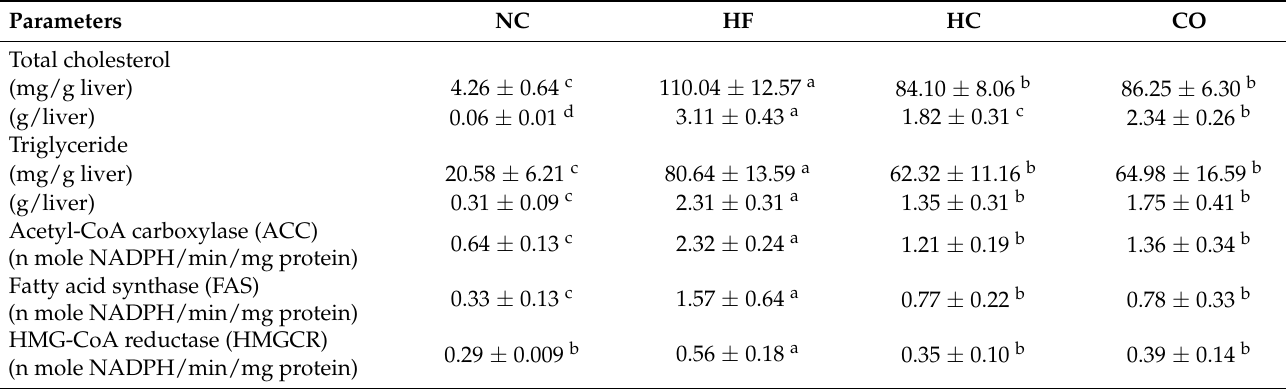
Table 4. The changes in liver lipids and lipid biosynthesis-related enzyme activities in rats fed with different experimental diets for 12